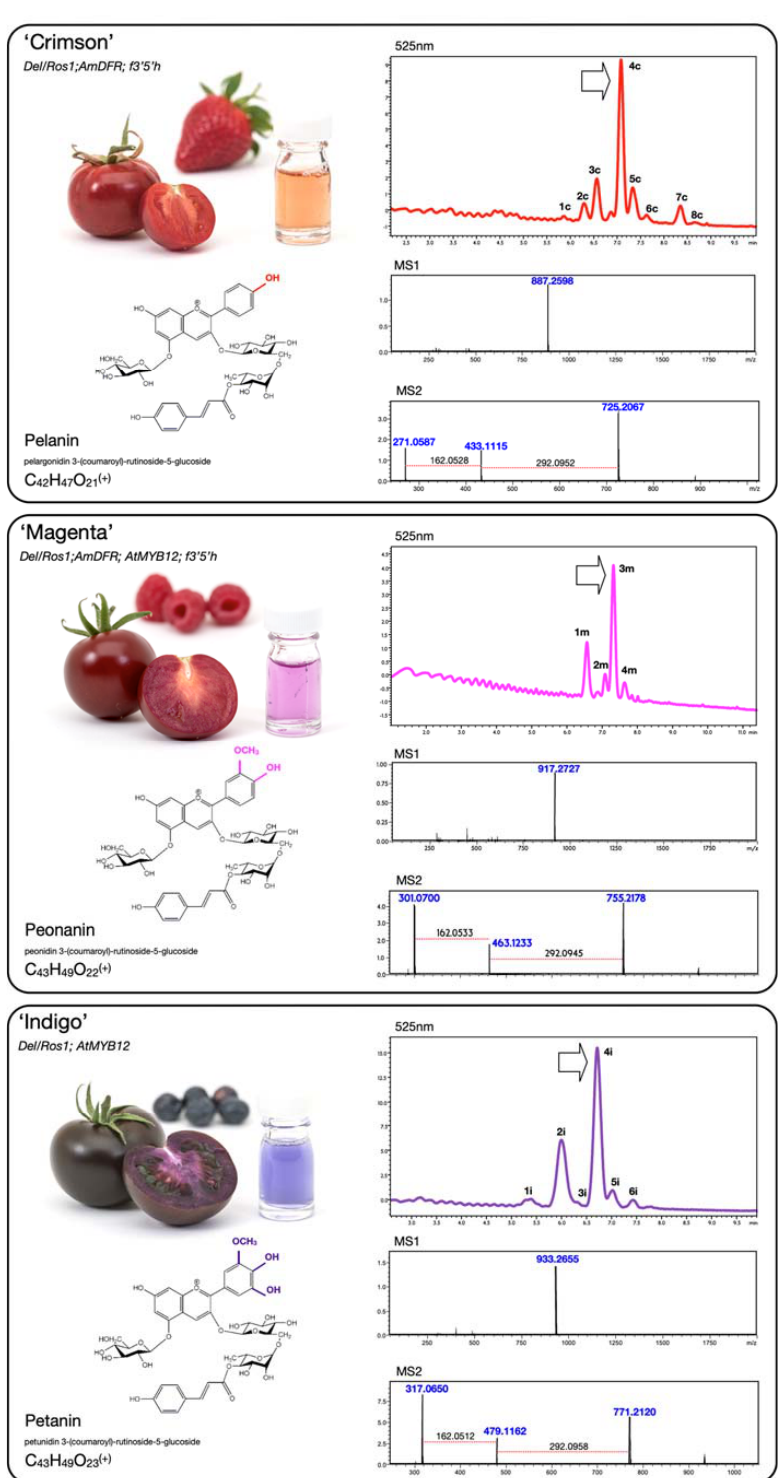
Figure 3. Fruit phenotypes and metabolic analyses of fruit juice extracted from ‘Crimson’, ‘Magenta’ and ‘Indigo’ tomatoes in a Money Maker-like background. For each variety, anthocyanins were analysed using HPLC, and MS1/MS2 spectra are provided for the most abundant peaks, indicated by arrows. Chemical structures, names and formulae of the corresponding compounds are reported. The glass vials contain tomato juice after centrifugation and dilution for better representation of juice colour. The anthocyanins (P1, C2 and D3) engineered in tomato mimic the three classes naturally produced in strawberries, raspberries and blueberries, illustrated in the